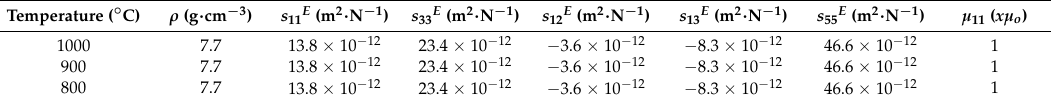
Table 2. Material coefficients for Bi 0.36 Pb 0.64 Sc 0.36 Ti 0.64 O 3 spark plasma sintered at decreasing temperatures: density ρ , elastic compliances s ijE , and magnetic permeability µ 11 .